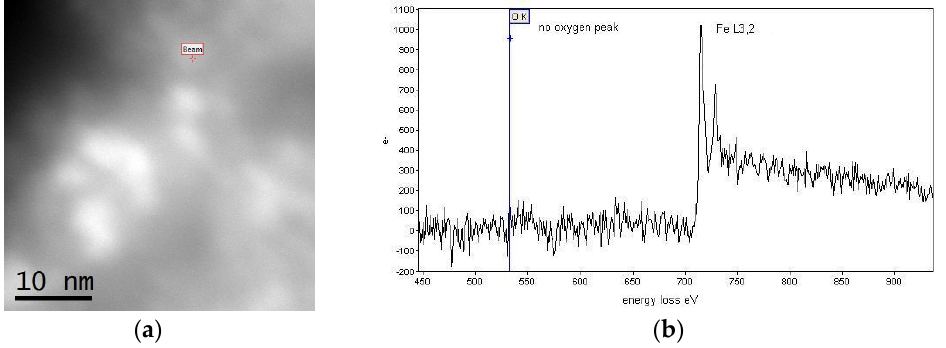
Figure 11. ( a ) An example of TEM image from EELS (electron energy ‐ loss spectroscopy) analysis; ( b ) EELS spectrum from image ( a ) (only iron peaks were detected).